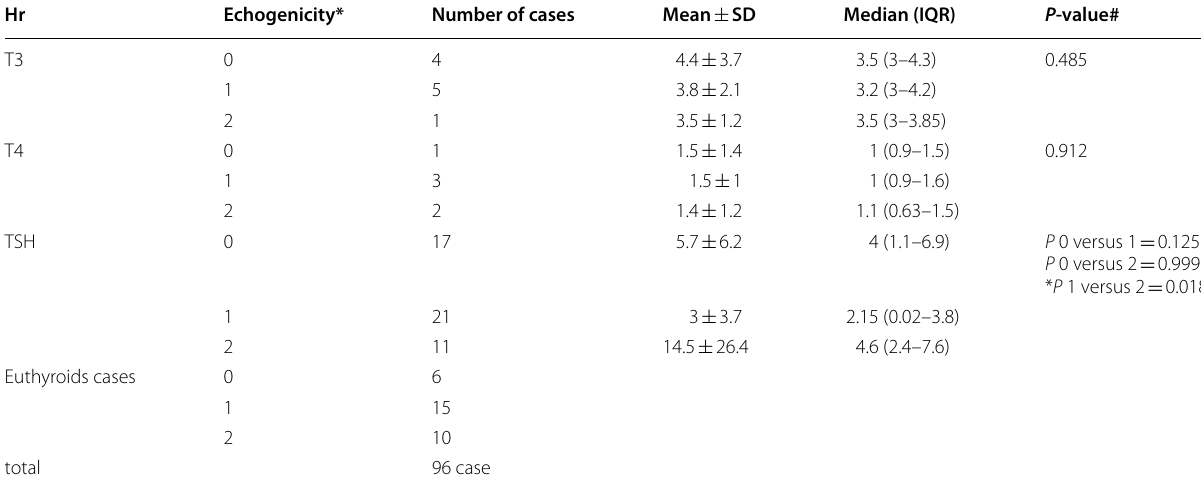
Table 1 Relation between thyroid gland echogenicity and thyroid hormonal level in studied cases